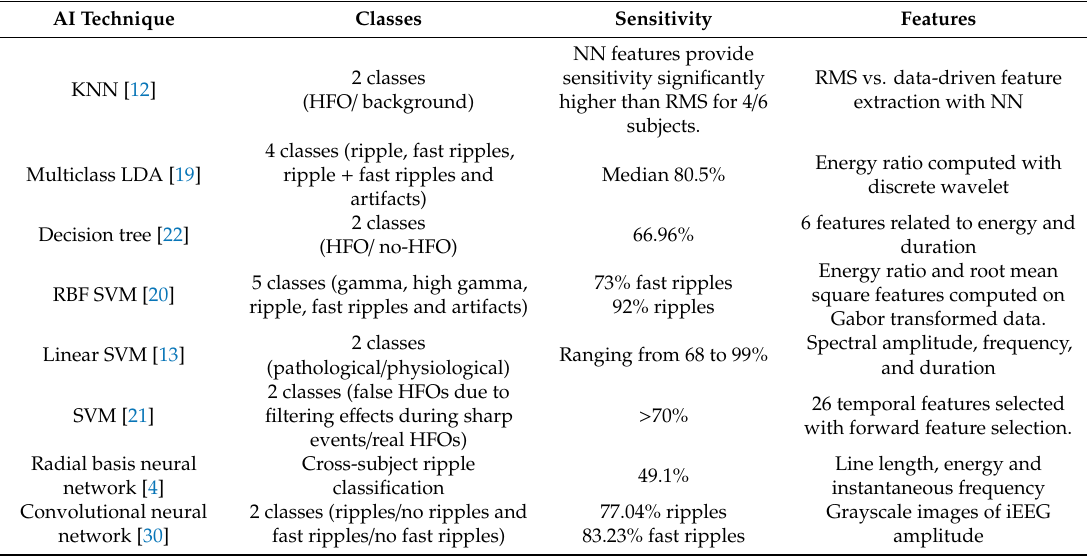
Table 1. Applications of artificial intelligence for HFO